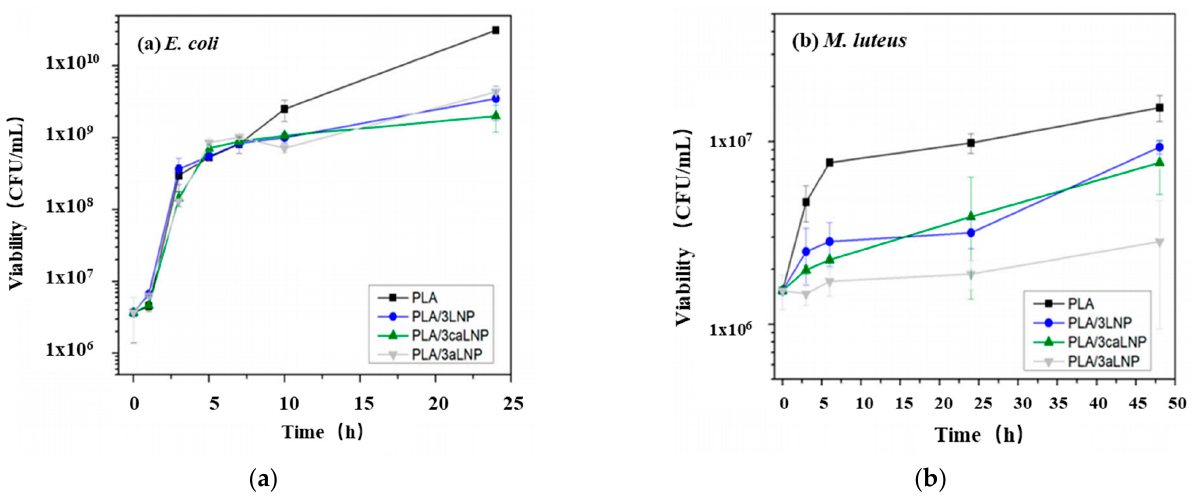
Figure 8. Antibacterial activity tests for PLA and PLA nanocomposite films containing 3 wt % of fillers ( a ) against Escherichia coli ; ( b ) against Micrococcus luteus. Ref. [92] , published by MDPI, 2020.